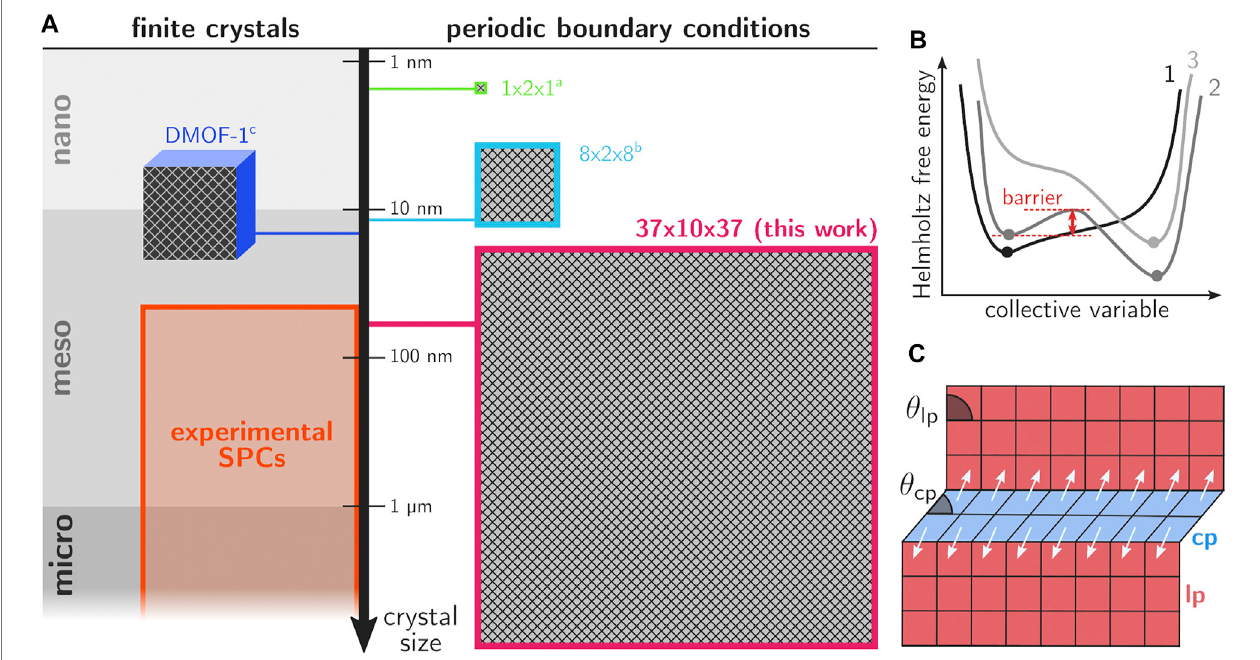
FIGURE1|(A) OverviewofthedifferentlengthscalesofcomputationalmodelsthatwereusedinpriorworkonphasetransitionsinSPCs,togetherwiththecurrent supercellcon fi gurationandtherangeofexperimental crystalsizesofMOFs.ForMIL-53(Al),the1 × 2 × 1cellwasemployedinVanduyfhuysetal.(2018)andthe8 × 2 × 8 cell in Rogge et al. (2019). The DMOF-1 crystallite is discussed in Keupp and Schmid (2019). (B) Conceptual Helmholtz free energy curves for conditions for which the materialshowsasinglestablephase(curves1and3)ortwo(meta)stablephasesseparatedbyanenergybarrier(curve2). (C) Schematicillustrationofthelayer-by- layer transition mechanism in